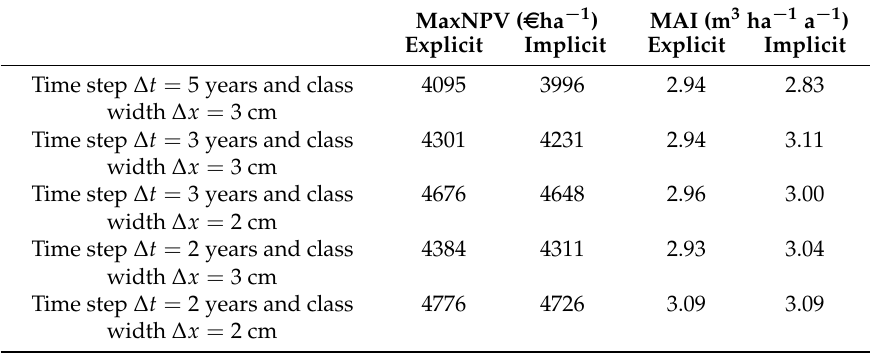
Figure 2. Diameter distributions associated with optimal thinnings of problem (14) with state equation approximated by implicit scheme (11). Numbers (e.g., 5–8, 11–14) represent diameter in centimetres. Table 1. Maximum net present values, MaxNPVs, (i.e., optimal cost function values of the problem (14)) and mean annual increments (MAI) associated with optimal stand-level managements. Initial density is 1000 stems ha − 1